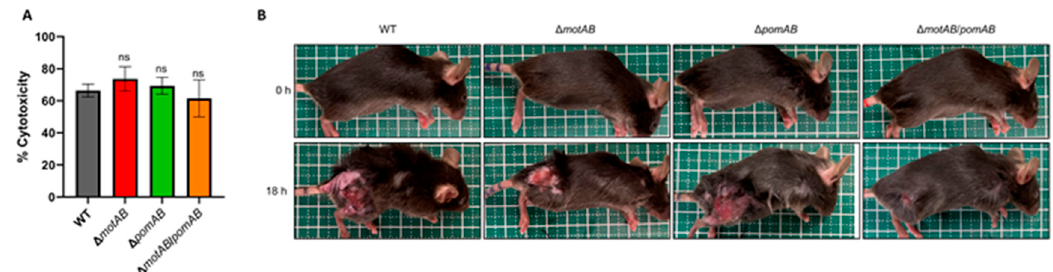
Figure 2. Soft tissue lesions in the A. hydrophila wound infection model. ( A ) Cytotoxicities against HeLa cells ( n = 6/group, MOI = 10) were determined by measuring the activity of LDH released from damaged cells at 2 h post-infection. Error bars indicate SEM. ns, not significant ( p > 0.05) compared with WT; Mann-Whitney U -test. ( B ) Mice were s.c.-inoculated with WT, Δ motAB , Δ pomAB , and Δ motAB / pomAB. Pictures show infected mice at 0 h and 18 h post-infection.